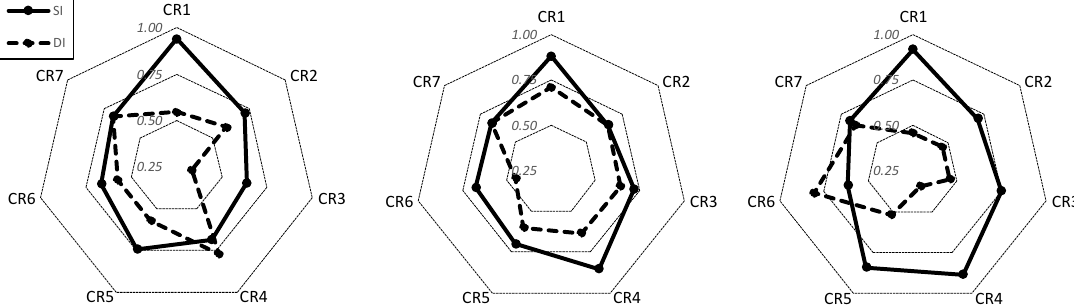
Figure 4. Satisfaction index (SI) and Dissatisfaction index (DI) in seven requirements relative to year of study; first year students ( left ), second year students ( center ) and third year students ( right ).